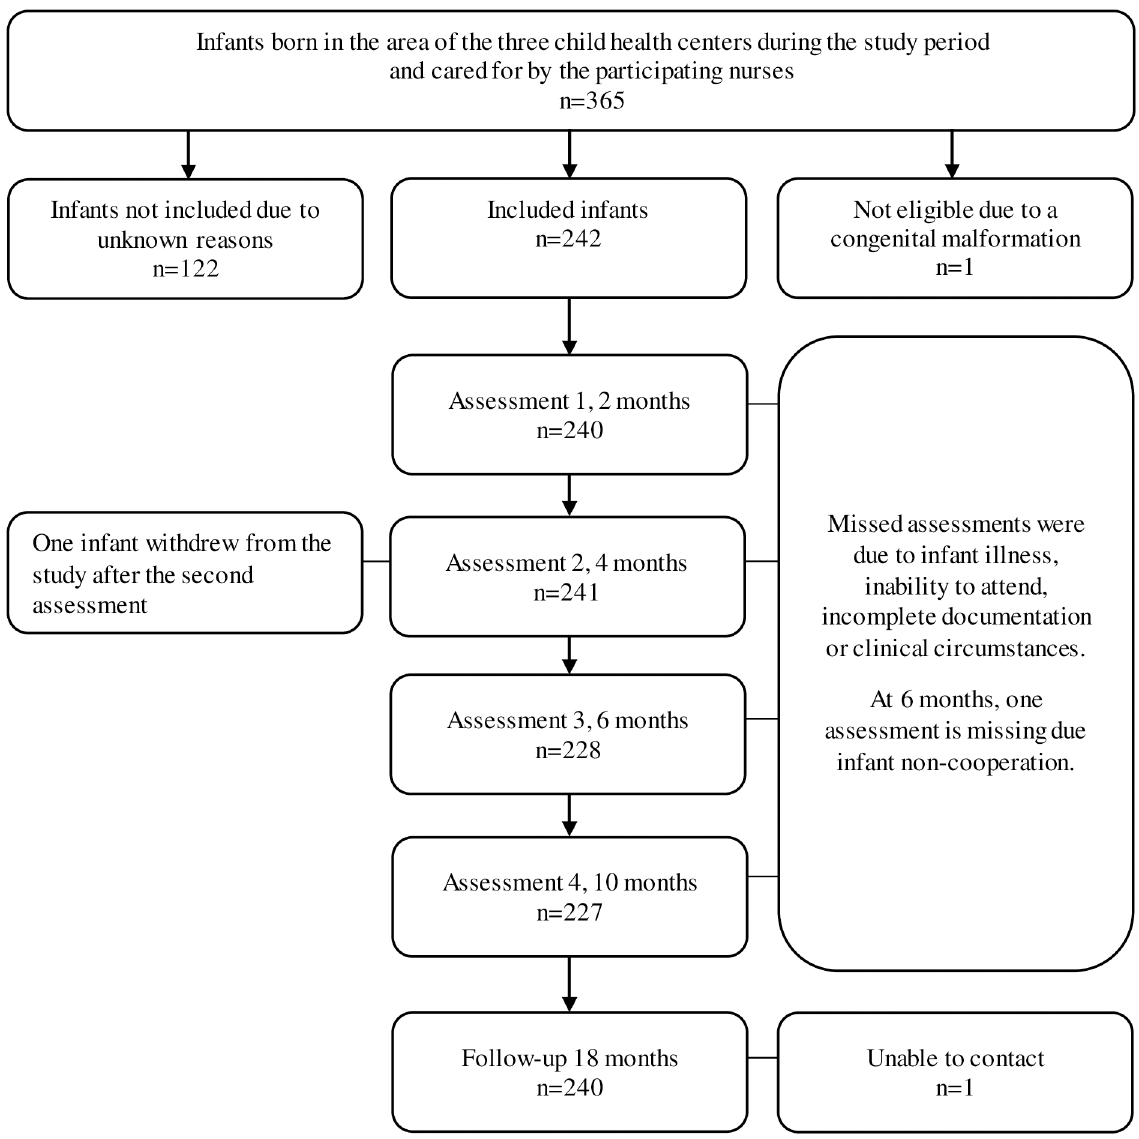
Fig 1. Flow-chart of recruitment and follow-up